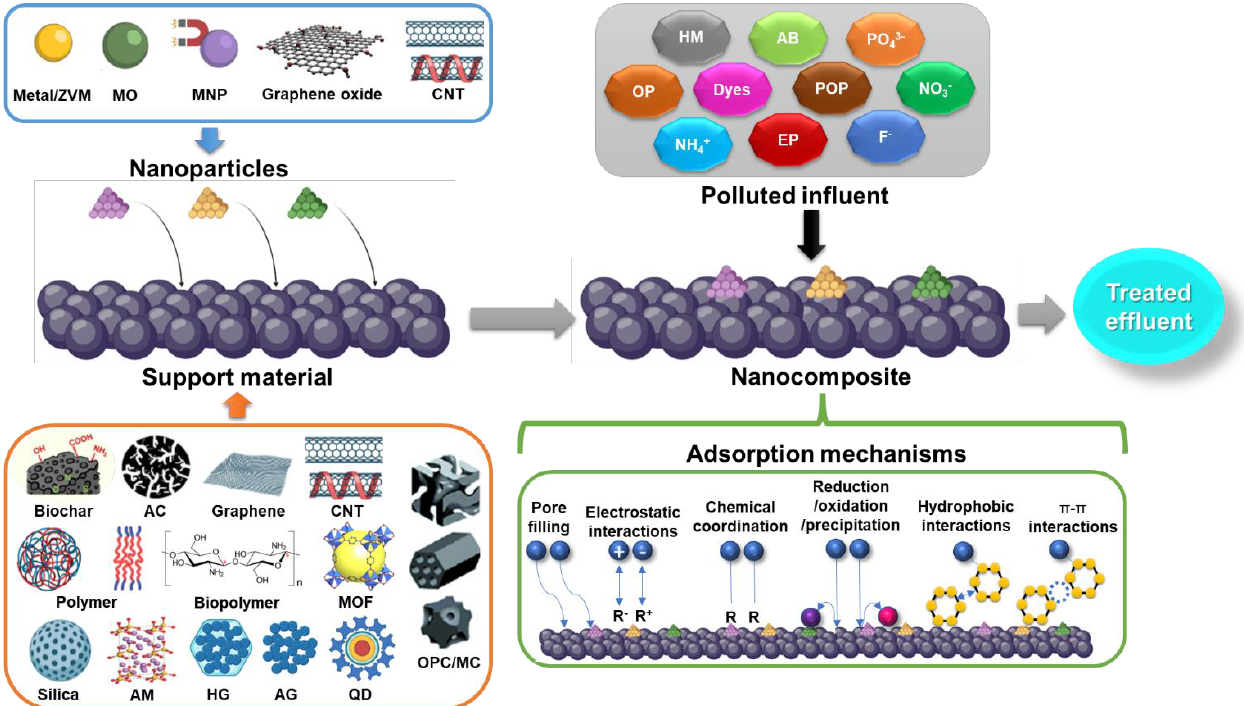
Figure 3 . Scheme of nanoparticle immobilization on different supporting materials for the treatment of polluted discharges through adsorption processes. AB, antibiotic; AC, activated carbon; AG, aerogel; AM, alkali-metal-based material; CNT, carbon nanotube; EP, emerging pollutant; HG, hydrogel; HM, heavy metal; MC, monolithic carbon; MO, metal oxide; MOF, metal organic framework; MNP, magnetic nanoparticle; OP, organic pollutant; OPC, ordered porous carbon; POP, persistent organic pollutant; QD, quantum dot; ZVM, zero valent metal.